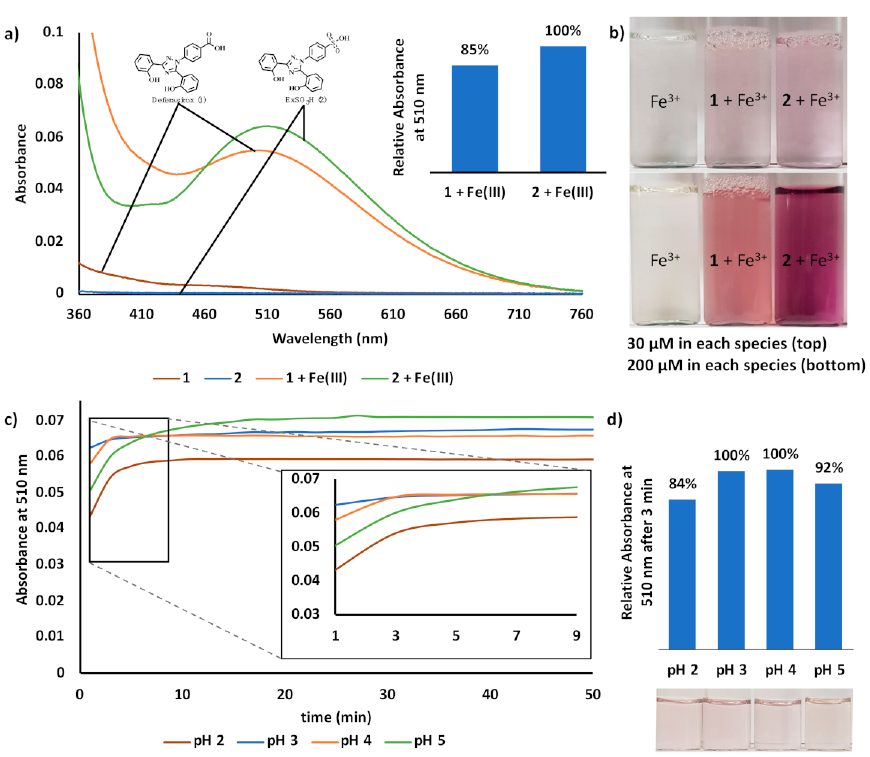
Figure 1. ( a ) Absorbance spectra of 1 and 2 (both at 30 µ M) in the absence and presence of one molar equivalent of Fe 3+ in acetate buffer at pH = 3. ( b ) Photos of FeCl 3 in the absence and presence of 1 or 2 at 30 µ M and 200 µ M at pH = 3, respectively. ( c ) Time profile of the absorbance at 510 nm for 30 µ M 2 and 30 µ M Fe 3+ (as FeCl 3 ) in aqueous acetate buffer solutions at the indicated pH. ( d ) Relative absorbance at 510 nm after incubating for 3 min in an acetate buffer at the indicated pH (top) and pictures of the corresponding solutions